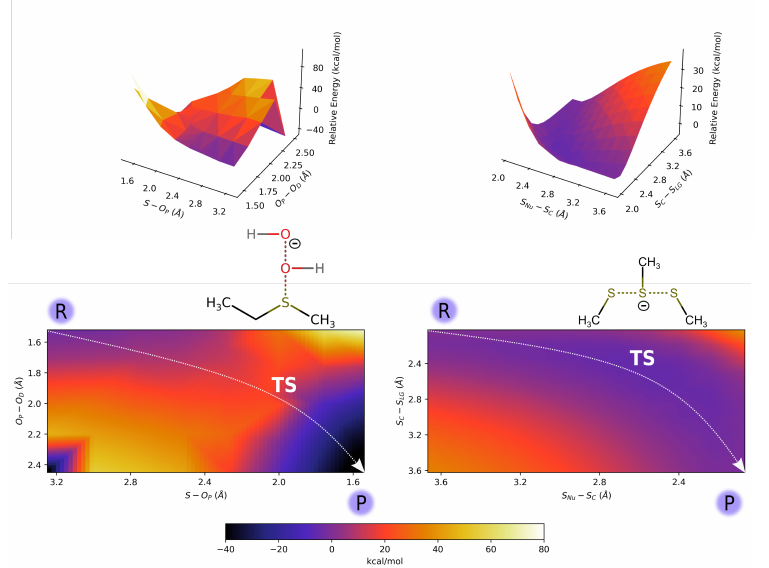
Figure 1. In vacuum 2D and 3D energy scan for ethyl methyl sulfide oxidation ( left ) and thiol/disulfide interchange reaction ( right ). The TS structures of corresponding QCs are reported in